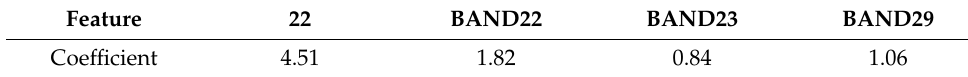
Table 16. Interaction characteristic coefficients of metal